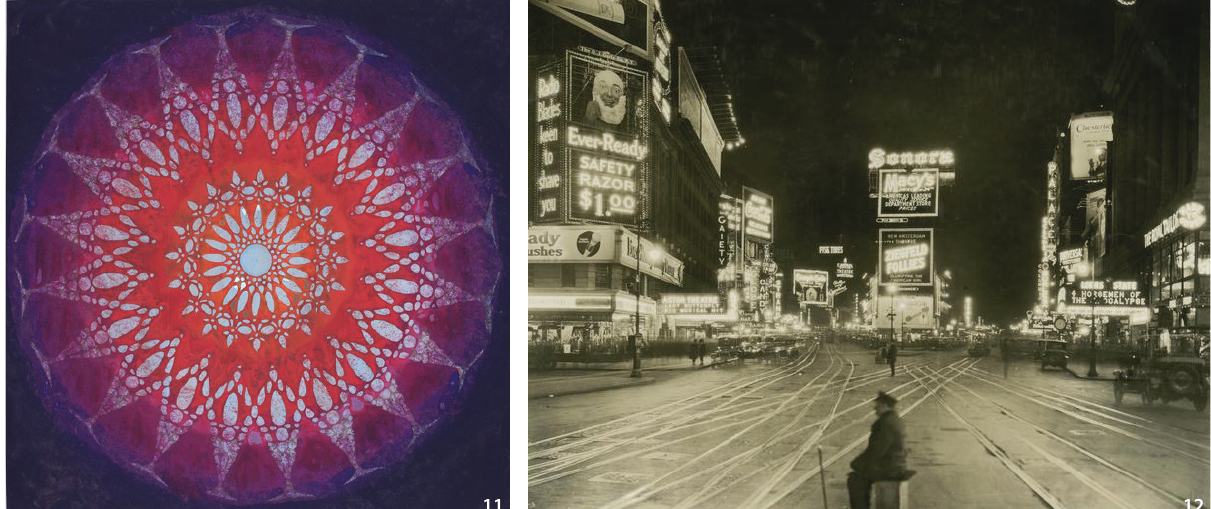
Figure 11 Claude Fayette Bragdon, Coloured Decorative Design (Source: The Miriam and Ira D. Wallach Division of Art, Prints and Photographs: Art & Architecture Collection, The New York Public Library. ‘Coloured decorative design’ New York Public Li- brary Digital Collections. Accessed June 27, 2019). Figure 12 The Great White Way: Broadway north from 45 th Street, 1923 (Source: The Miriam and Ira D. Wallach Division of Art, Prints and Photographs: Photography Collection, The New York Public Library. ‘Broadway north from 45th St.’ New York Public Library Digital Collections. Accessed June 27, 2019)